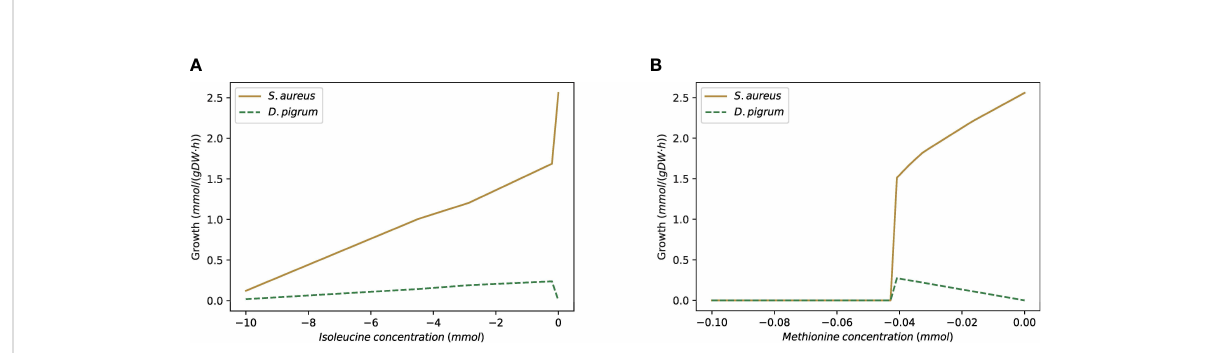
FIGURE 11 The custom model with SNM3 medium is used as D. pigrum appears in the absence of L-isoleucine and L-methionine and then without growth on SNM3. S. aureus provides both necessary amino acids for D. pigrum . (A) Shows the change of L-isoleucine in the community while ( D. pigrum has no growth. (B) Shows the change of L-methionine in the community while D. pigrum has no growth.